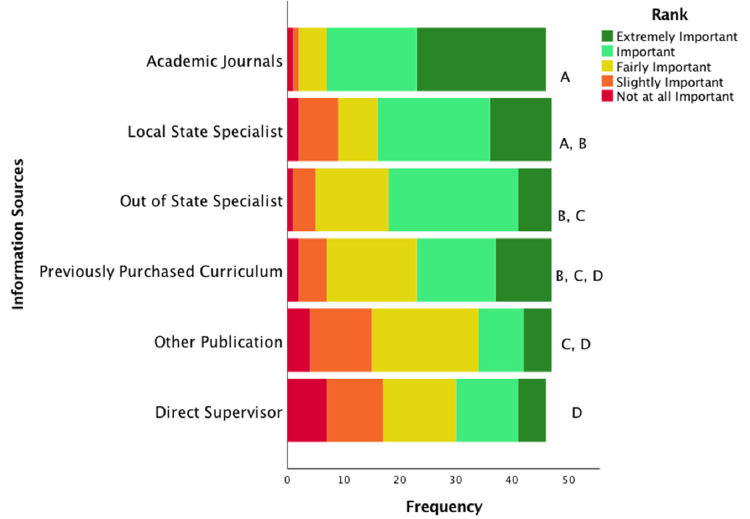
Figure 1. Specialists’ Information Sources. These data are reported in a frequency format with color-coded stacked bars representing the frequency of the sample that valued each information source. Information sources are listed in order of significance. Lettering at the end of the bars were indicates statistical differences between each source. That is, each letter indicates the presence of a statistically